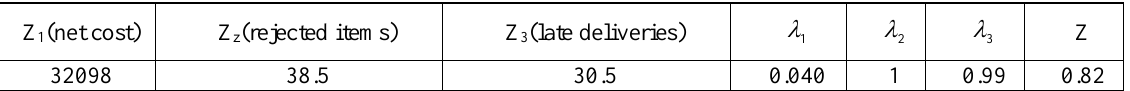
= 0.18, 𝑤 = 0.54, 𝑤 = 0.28 ). 1 2 2